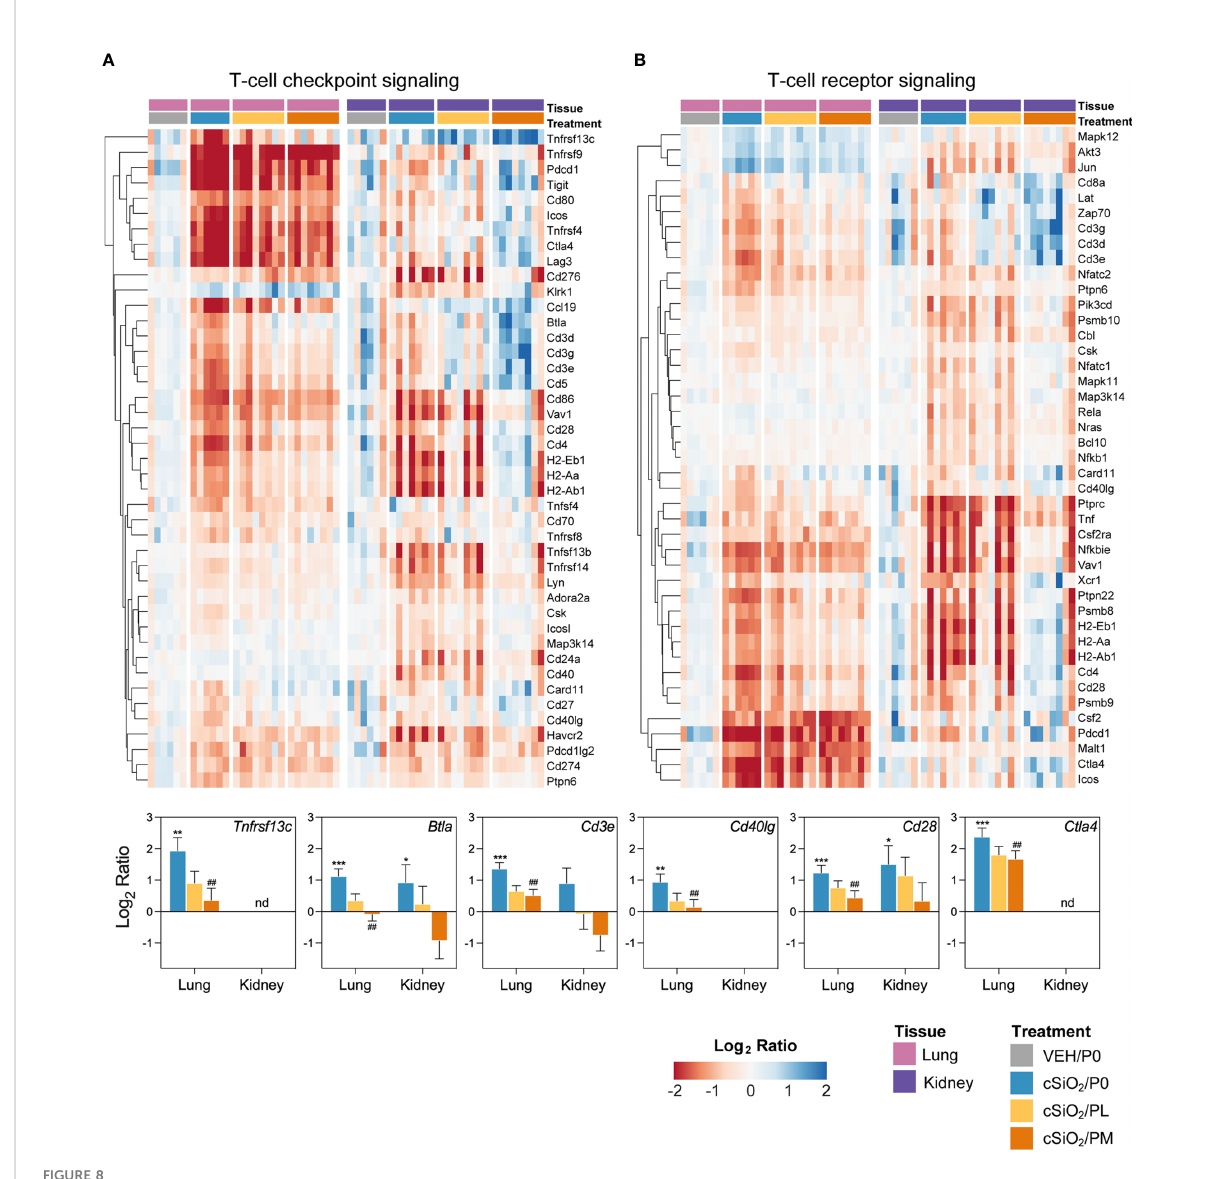
FIGURE 8 Comparison of prednisone-responsive genes associated with (A) T-cell checkpoint signaling and (B) T-cell receptor signaling pathways in lung or kidney tissues 14 weeks post instillation with cSiO 2 . Gene expression data were obtained using the NanoString Autoimmune Pro fi ling gene panel and are shown as log2 ratios for cSiO 2 /P0, cSiO 2 /PL, and cSiO 2 /PM treatment groups with respect to the tissue-matched VEH/P0 control group (log2 ratio = 0). For each pathway, heatmaps with unsupervised hierarchical clustering (Euclidian distance method) by gene show log2 expression values for all genes identi fi ed as differentially expressed in response to either cSiO 2 exposure or moderate-dose prednisone (FDR q<0.05, 1.5-fold change) in either of the selected tissues. The mean log2 ratio values + SEM for selected genes of interest are also shown. For cSiO 2 /P0 as compared to VEH/P0, *, FDR-corrected q<0.05; **, q<0.01; and ***, q<0.001. For cSiO 2 /PL or cSiO 2 /PM vs cSiO 2 /P0, ##, FDR-corrected q<0.01. nd stands for not detected. See Supplementary File 1 for test speci fi cations and FDR-corrected q-values for all genes in the panel for all comparisons. cSiO 2 , crystalline silica; P0, zero prednisone; PL, low-dose prednisone; PM, moderate-dose prednisone; VEH, vehicle